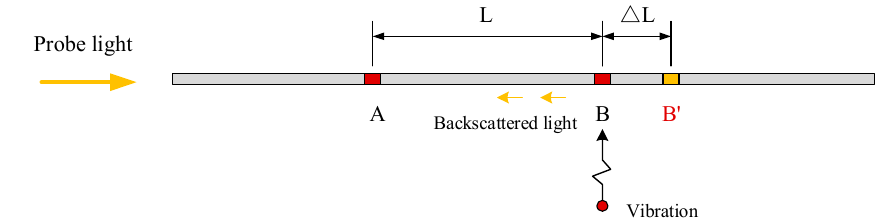
Figure 2. Principles of dynamic strain and its influence on the phase.